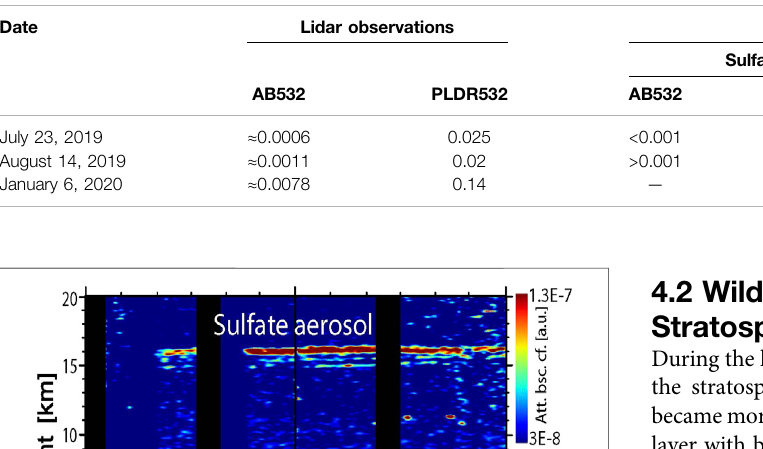
TABLE 3 | CALIPSO aerosol classi fi ciation. On 23 July and August 14, 2019, the aerosol typing criteria for sulfate aerosol were ful fi lled. On January 6, 2020, smoke aerosol was successfully identi fi ed. The classi fi cation was based on mean values (lidar observations) of the 532 nm attenuated backscatter value (AB532 in sr − 1 ) and particle lineardepolarizationratioPLDR532 measured alongthe fl ighttrackswithinthelatitudinalrange from45 ° – 54 ° Nand fortheheightrangefrom 14to17 km(23 July, Figure 2 ), from 50 ° – 58 ° N and 10.3 – 14.5 km height ( Figure 5 August 14), and from 47 ° – 56 ° N ( Figure 6 , January 6).